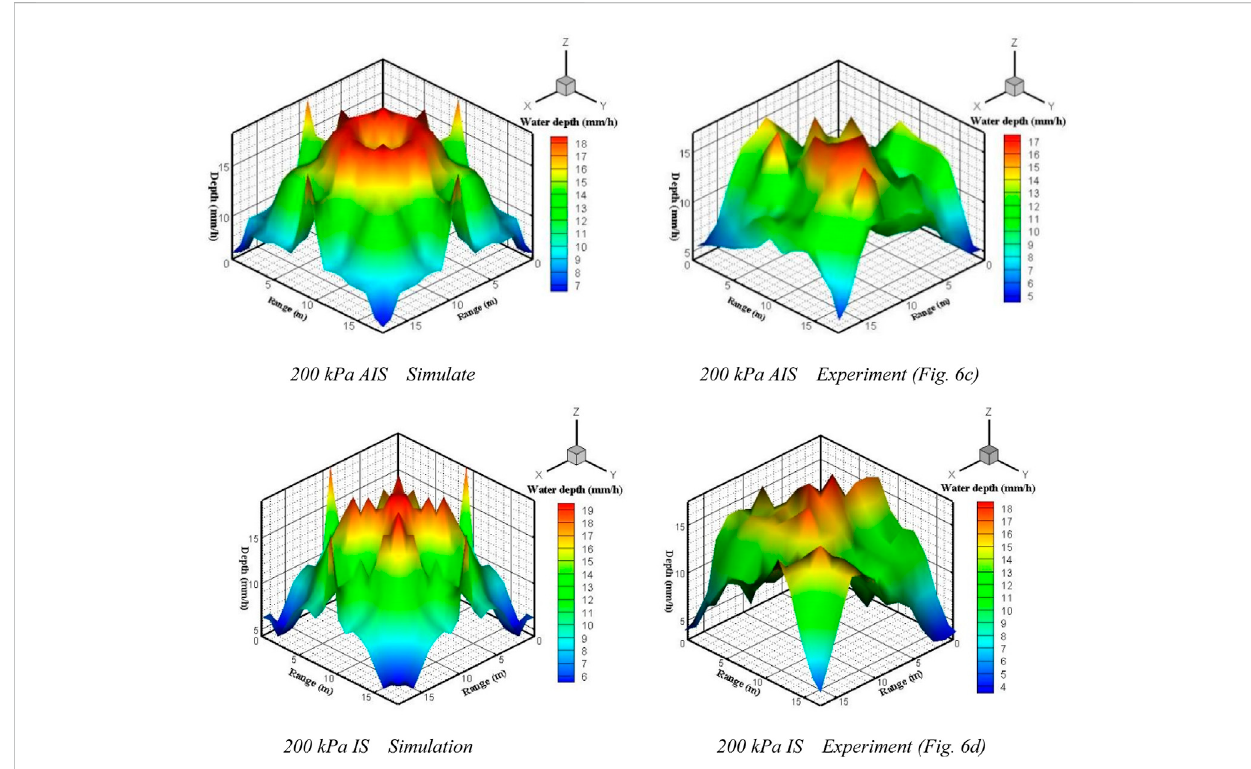
FIGURE 8 Simulated 3-D graph of the AIS and the IS and compared with experimental data. AIS, aerated impact sprinkler; IS, impact sprinkler. 200 kPa AIS Simulate 200 kPa AIS Experiment (Figure 6C) 200 kPa IS Simulation 200 kPa IS Experiment (Figure